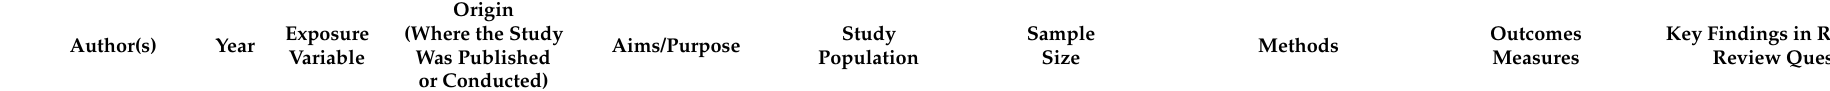
Table 1. Details of all studies meeting exposure (nutrition, sleep, exercise) and schizotypy (SPD, schizotypy, schizotypal personality